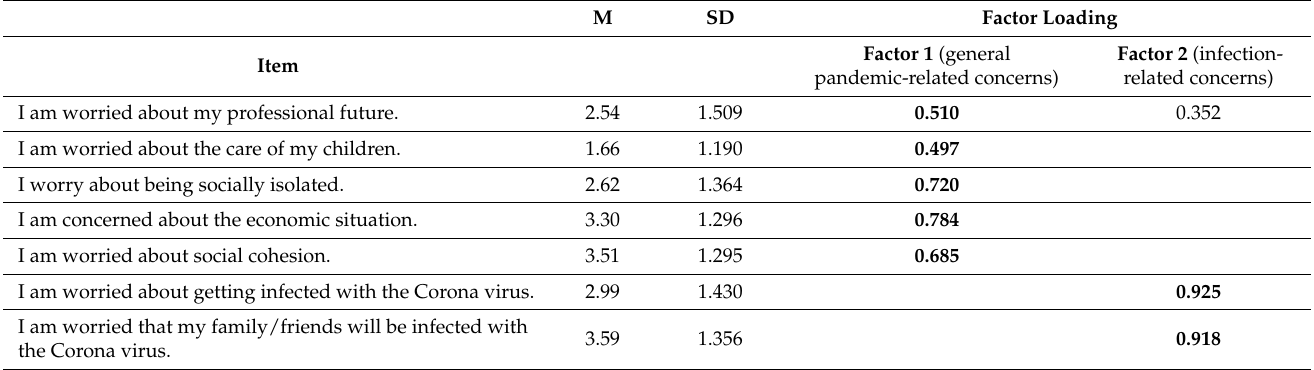
Table 2. Factor analysis of pandemic related